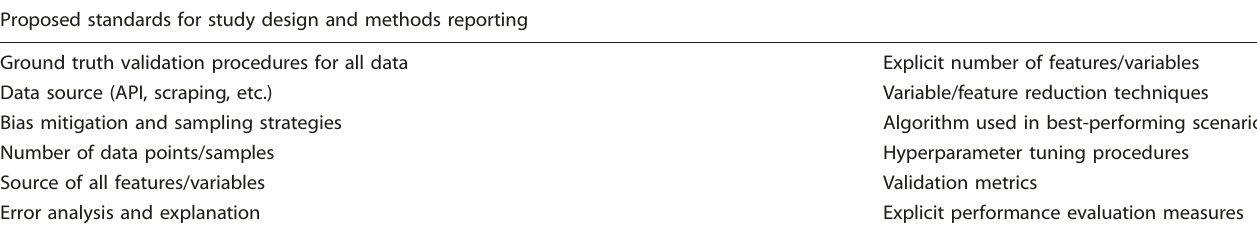
Table 1. Our recommendations for standards for reporting for methods and study